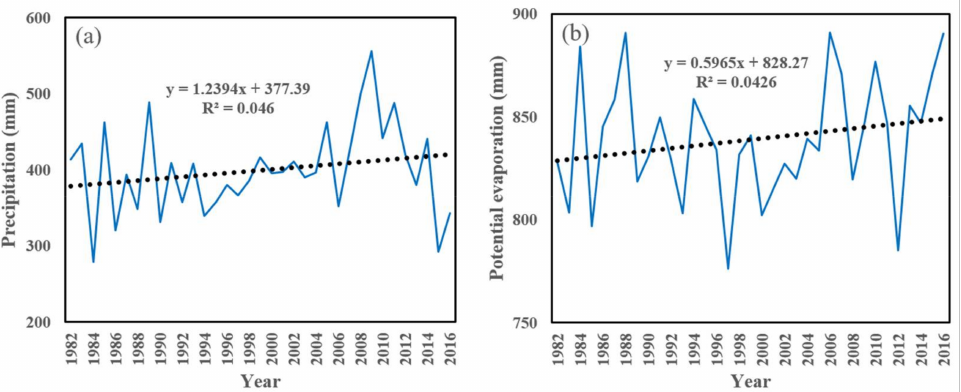
Figure 3. Variation trend of average precipitation ( a ) and average potential evaporation ( b ) in the